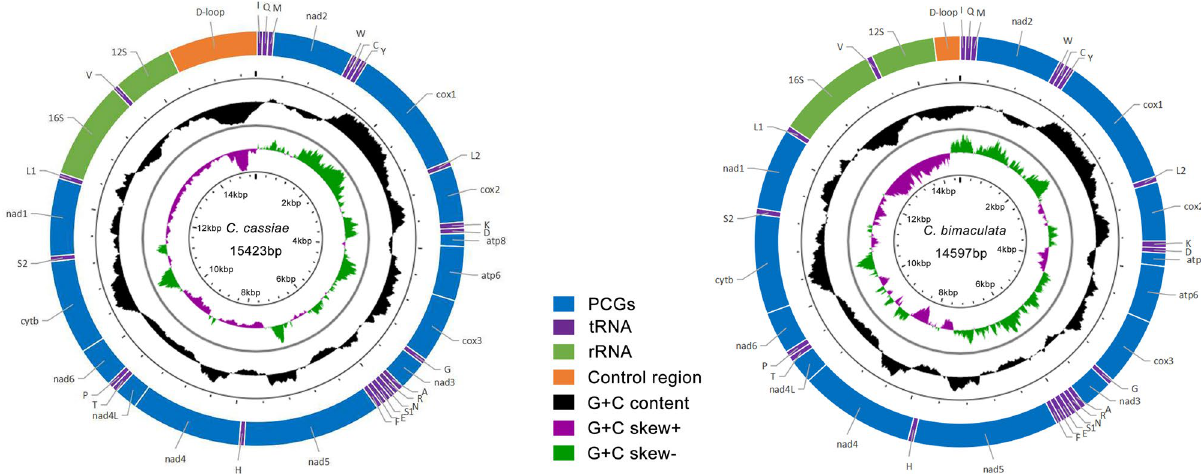
Figure 1. The organization of the mitogenomes of C. cassiae and C.